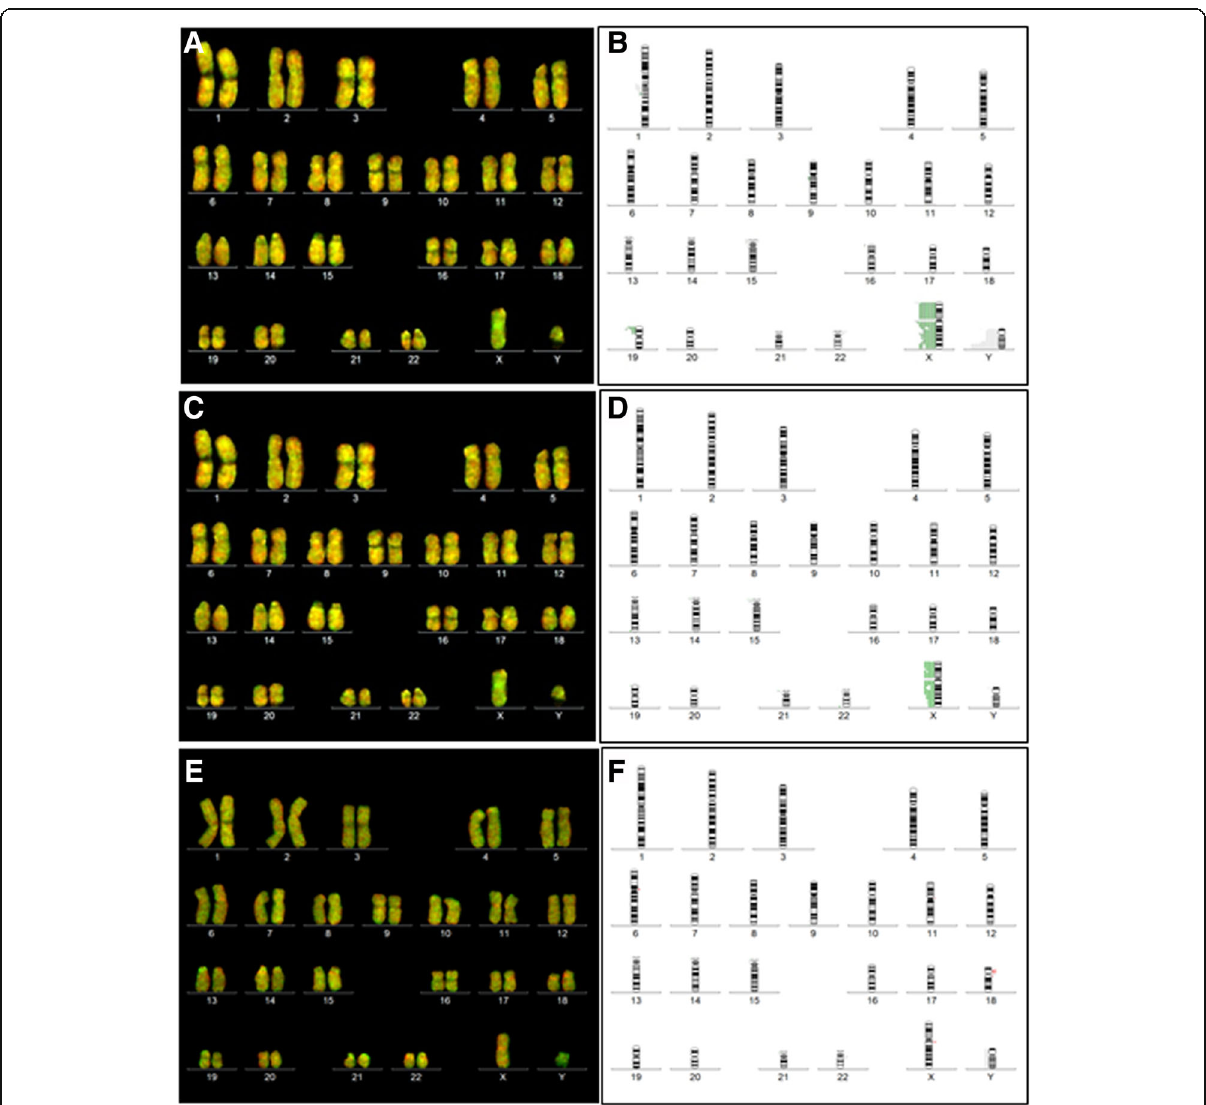
Fig. 4 Genetic stability of DPPSC, before and after osteogenic differentiation by sCGH analysis. a , b sCGH from undifferentiated DPPSC at passages 1, 5, 10 and 15 ( N = 6, XX and XY donors); a Fluorochromes image; b Fixed limits summary. c , d sCGH at day 21 of 2D osteogenic differentiation from DPPSC at passages 1, 5 and 10 ( N = 3, XX and XY donors). c Fluorochromes image; d Fixed limits summary. e , f CGH from DPPSC (P10) at day 21 of osteogenic differentiation on biomaterials: Collagen and Titanium carriers ( N = 2, XX donors). e Fluorochromes image; f Fixed limits summary. 47, XXY control samples (labeled in green ) and DPPSC samples (labeled in red ) were mixed and co-hybridized onto 12 (46, XY) metaphases in triplicate. A gain in the X or Y chromosome dosage was due to sex